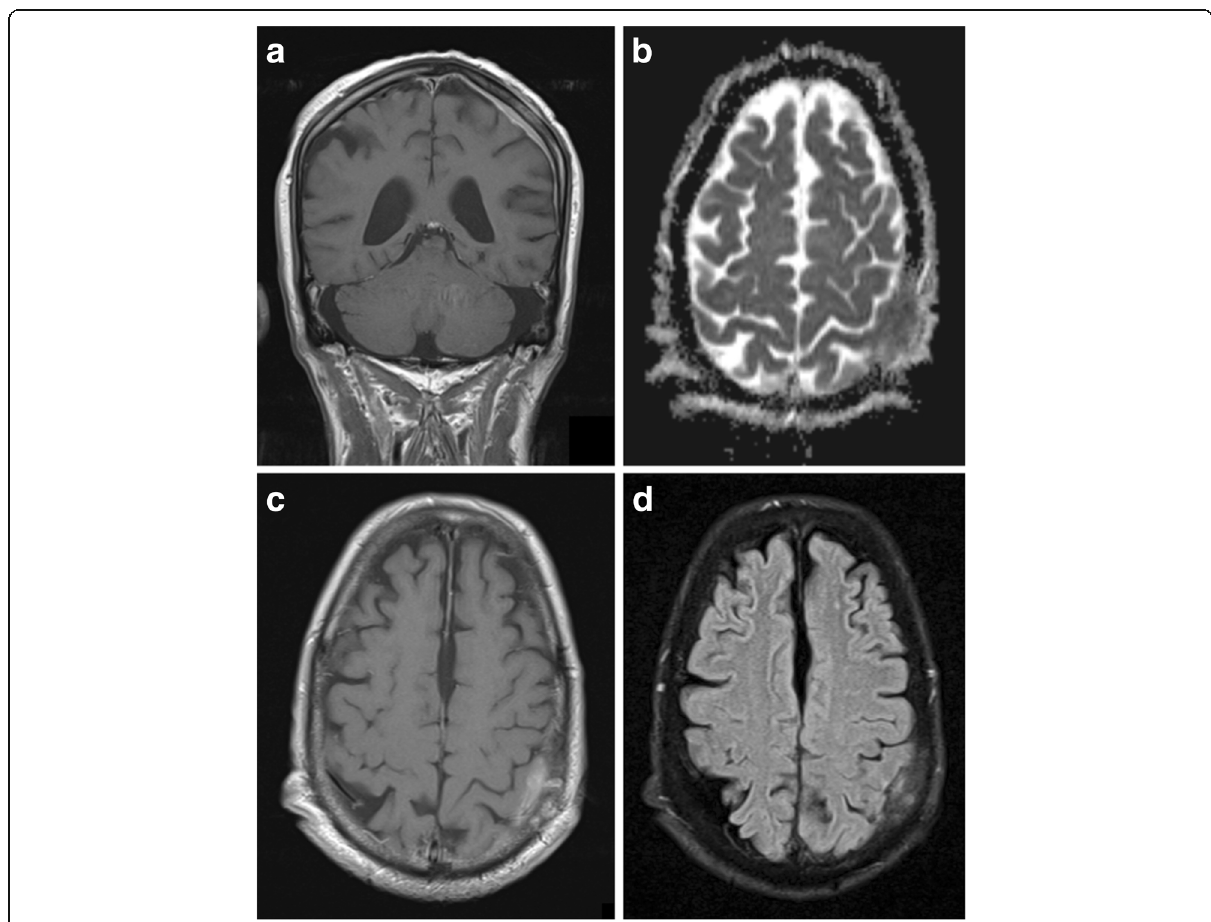
Fig. 13 IgG4-related hypertrophic pachymeningitis with skull invasion. a Post-contrast coronal T1-weighted MR image showing linear dural thickening and enhancement overlying the left cerebral convexity. Note that the overlying calvarial bone marrow signal is abnormal. b Apparent diffusion coefficient (ADC) map showing restricted diffusion in the lesion overlying the left parietal region. c Post-contrast axial T1-weighted image of the same lesion with enhancing soft tissue seen invading the skull. d Axial fluid attenuated inversion recovery (FLAIR) image showing the lesion is predominantly hypointense due to fibrosis with foci of